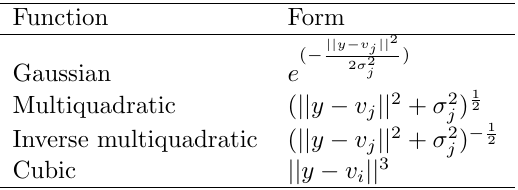
Table 1. Radial basis functions